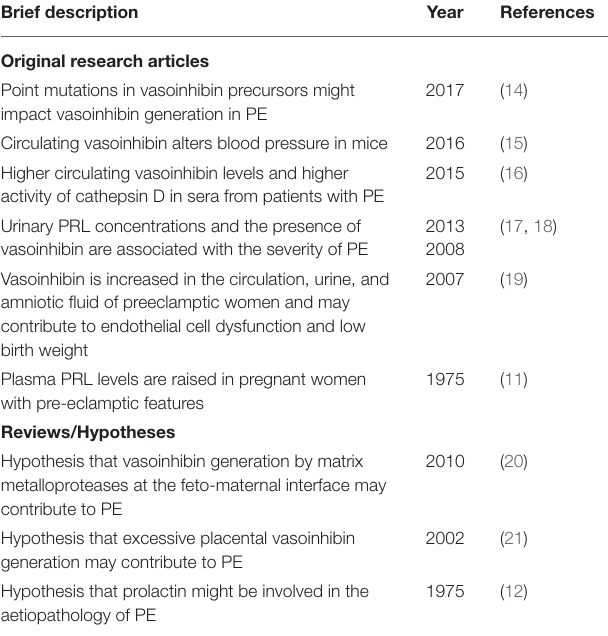
TABLE 1 | Selected original research articles and reviews supporting the involvement of the prolactin/vasoinhibin axis in